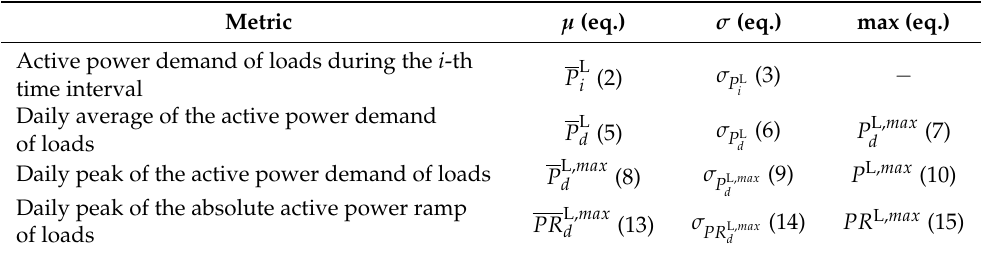
Table 1. Summary of the metrics and reference to the related equations adopted to analyze the load profiles. µ : average value, σ : standard deviation, max: maximum